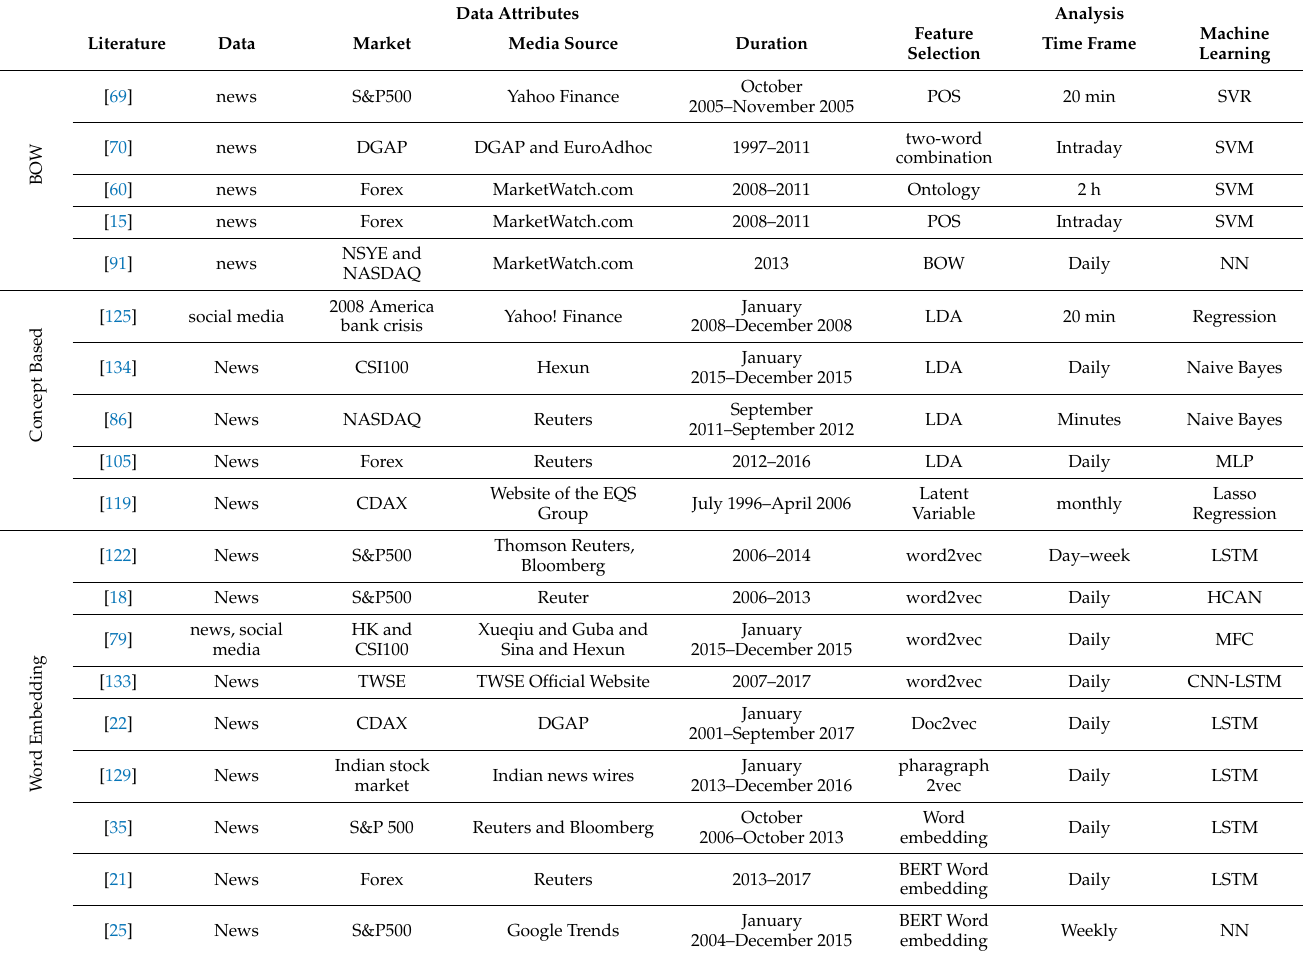
Table 2. Comparison of methods based on text representation